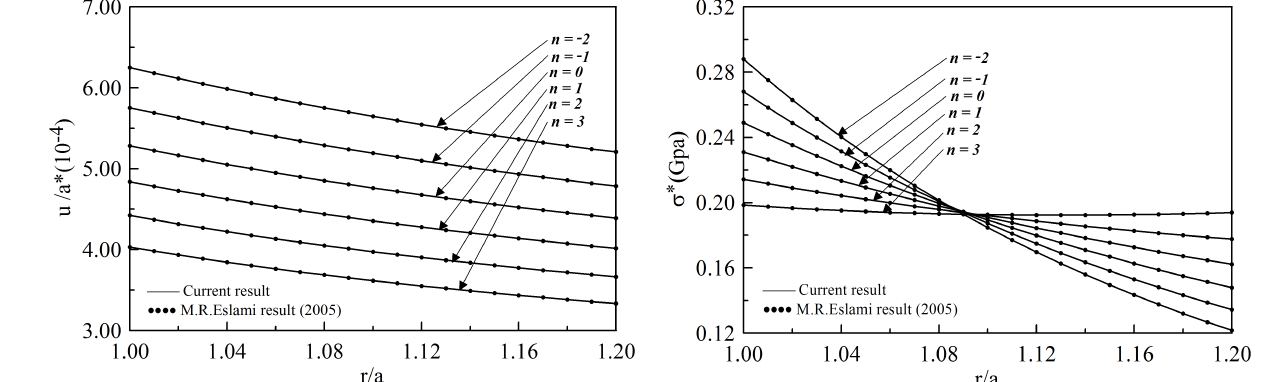
Figure 10: Radially distributed von-Mises stress for b/a =